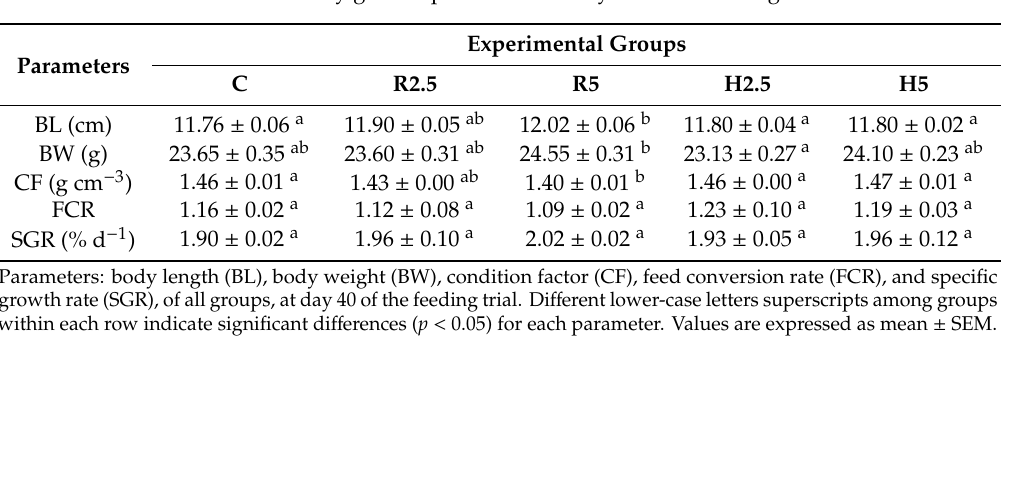
Table 2. Fish body growth parameters at day 40 of the feeding